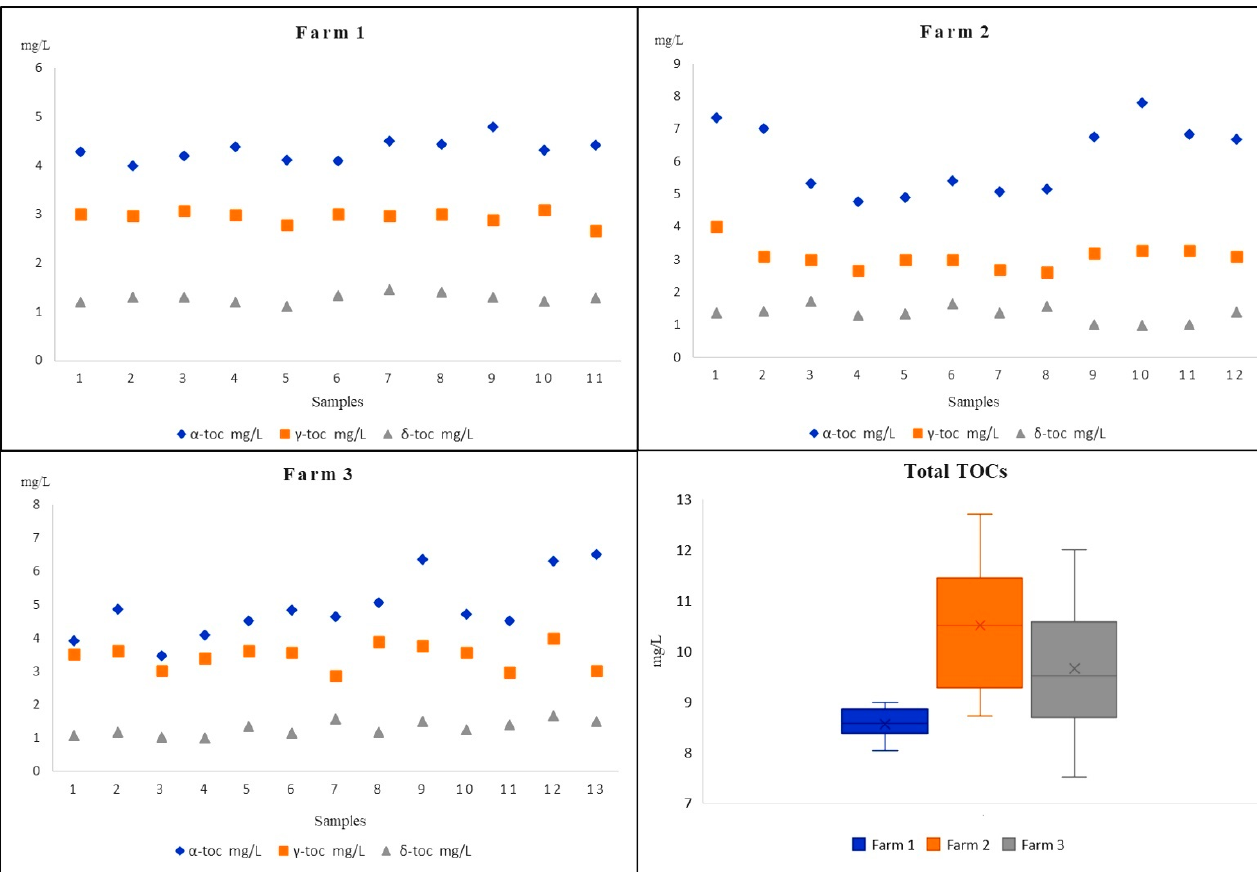
Figure 3. The TOCs’ content in different Modicana cow milks from three different farms.